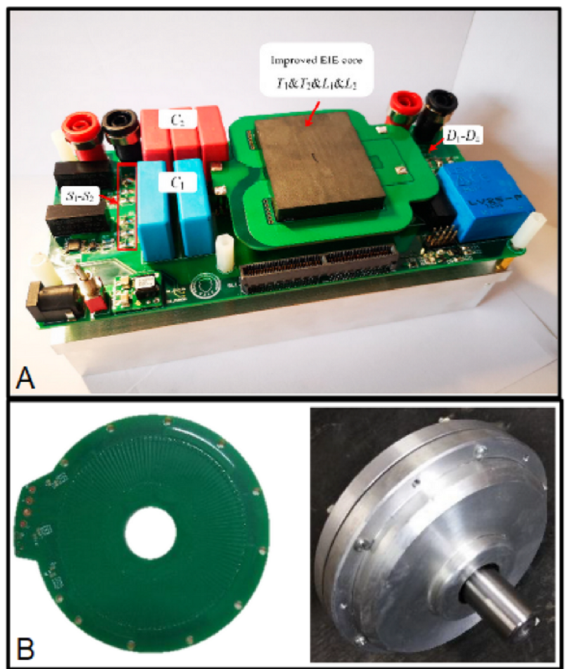
Figure 5. ( A ) PCB-based transformer integrated on a Printed Circuit Board (reprinted from [65], copyright (2020), Creative Commons License). ( B ) Improved PCB stator of a synchronous motor and prototype (reprinted from [67], copyright (2018), Creative Commons